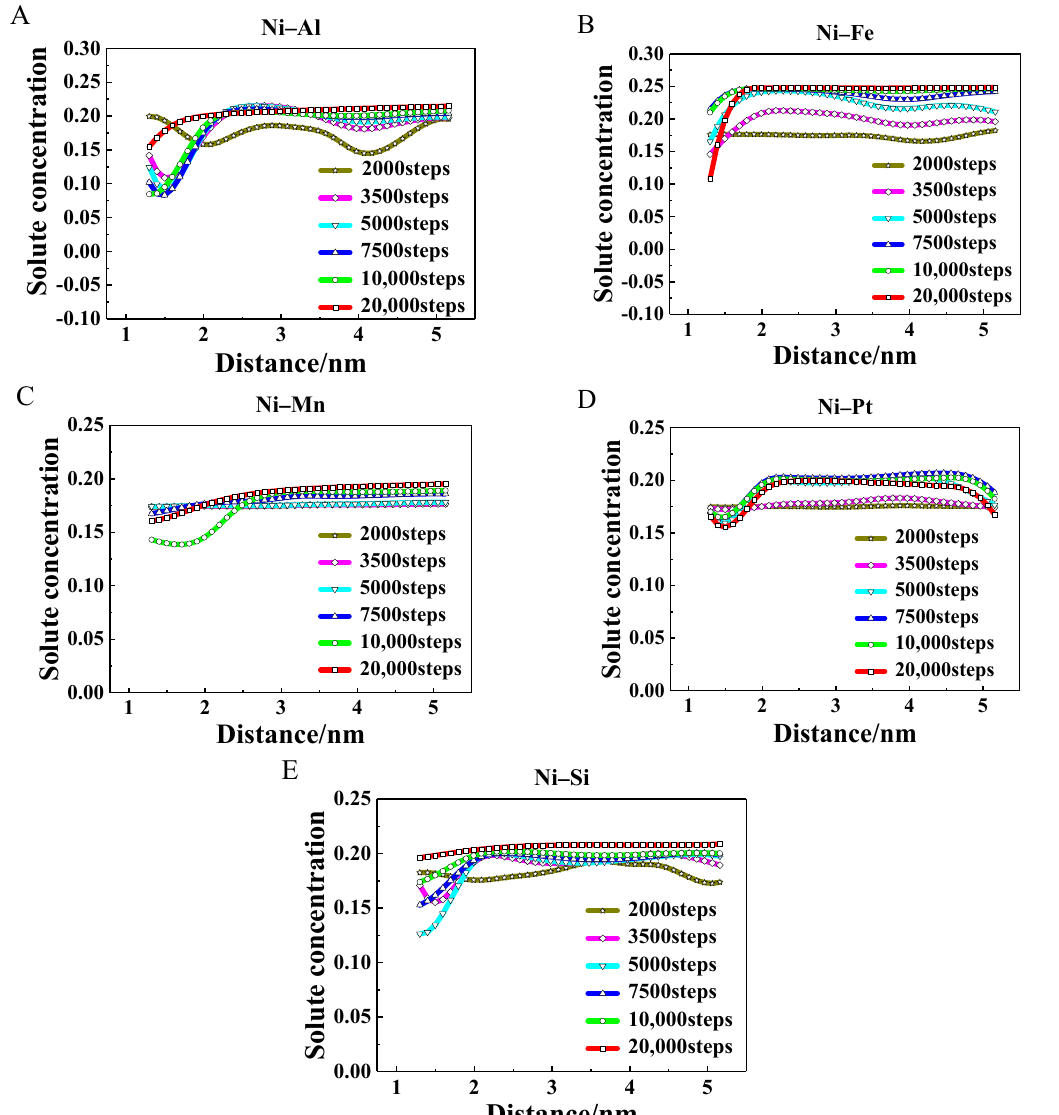
Figure 5. Variations of the solute concentration with distance for: ( A ) Ni–Al; ( B ) Ni–Fe; ( C ) Ni–Mn; ( D ) Ni–Pt; ( E ) Ni–Si.